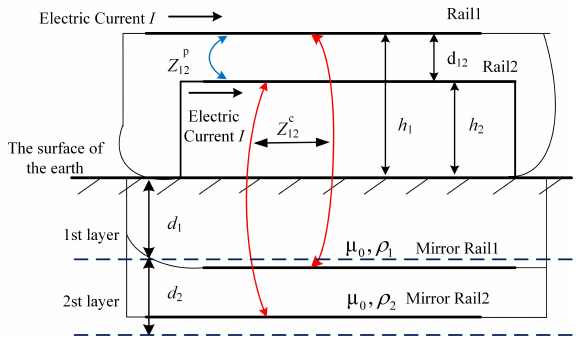
Fig. 2. Calculation model of rail external impedance.